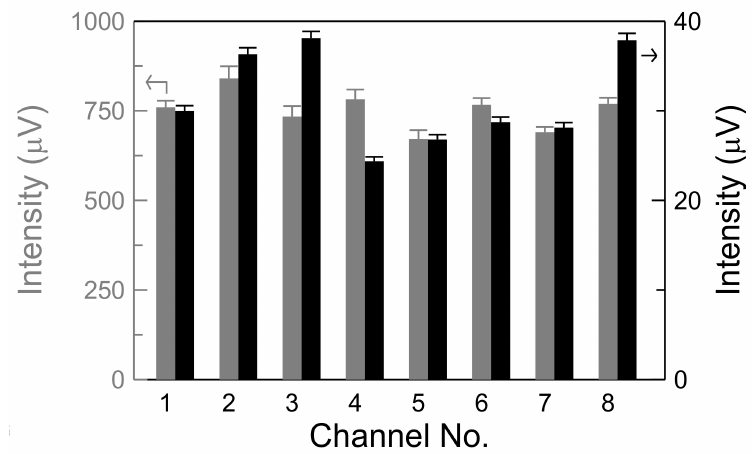
Figure 4. The consistency study of channels with the measurement of noise levels (black bars) and biomarker-free mixture (gray bars) without the bioconjugation